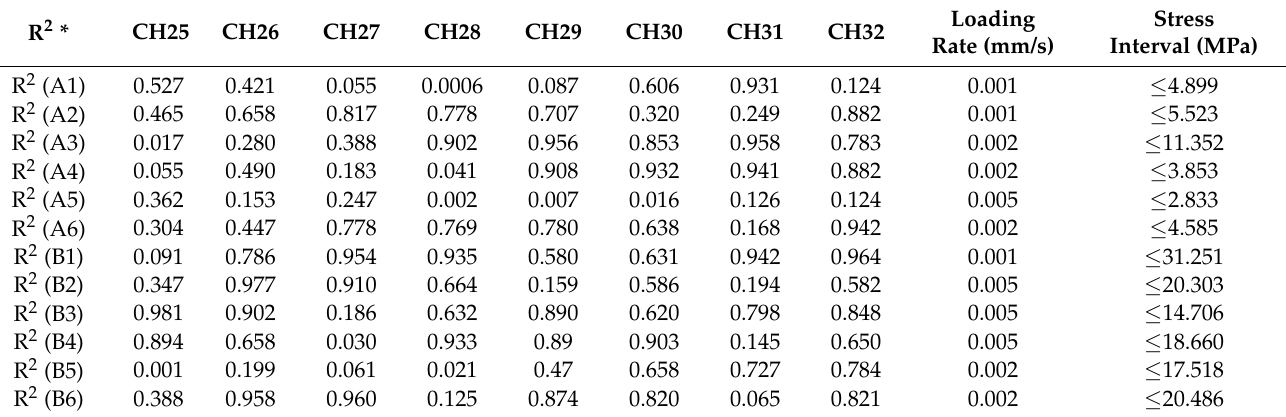
* Correlation coefficients R 2 marked in red were greater than 0.5. Samples A1 to A6 were drilled parallel to bedding and samples B1 to B6 were drilled perpendicular to bedding.